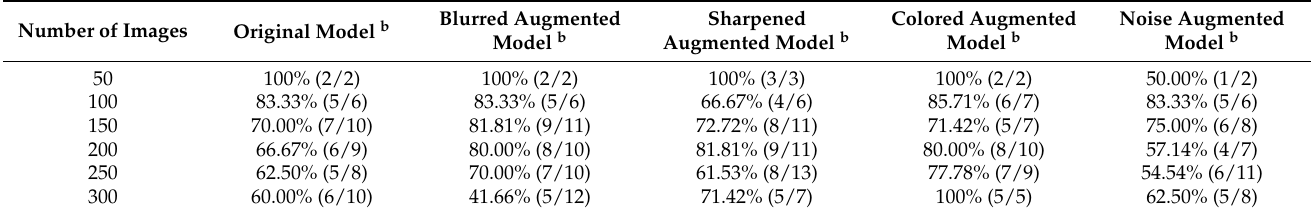
Table 4. The panoramic accuracy of each model.